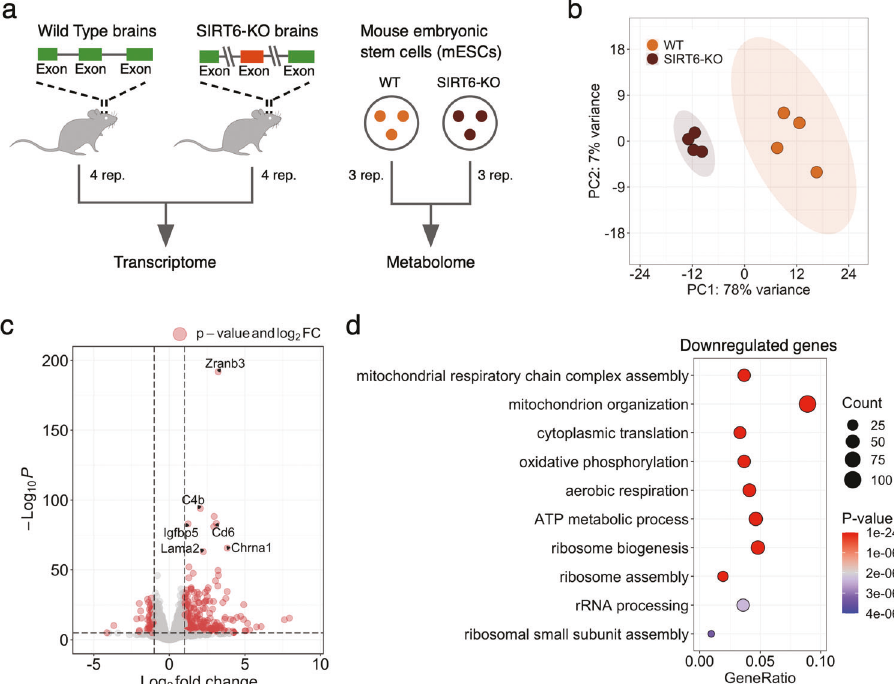
Fig. 1 SIRT6 regulates gene expression levels. a Schematic illustration of the experimental design used in this study. Transcriptome pro fi les were collected from Wild Type (WT) and SIRT6-knockout (brSIRT6-KO) mouse brain samples. WT and brSIRT6-KO SH-SY5Y metabolomic pro fi les were complemented with metabolomics data on mouse embryonic stem cells. b Principal Component Analysis (PCA) plot showing separation between WT (orange) and brSIRT6-KO (brown) samples. Orange and brown ovals represent con fi dence ellipses of WT and brSIRT6- KO groups. c The volcano plot showing up- and downregulated differentially expressed genes in brSIRT6-KO mice compared to WT mice. Red dots indicate signi fi cantly changed genes, and gray dots represent insigni fi cant genes. d GO analysis showing the top 10 enriched biological processes for downregulated genes. Each circle corresponds to the enriched GO term and varies in size according to the number of signi fi cant genes belonging to this term. The gene ratio represents the number of DE genes belonging to the enrichment categories divided by the total number of genes per